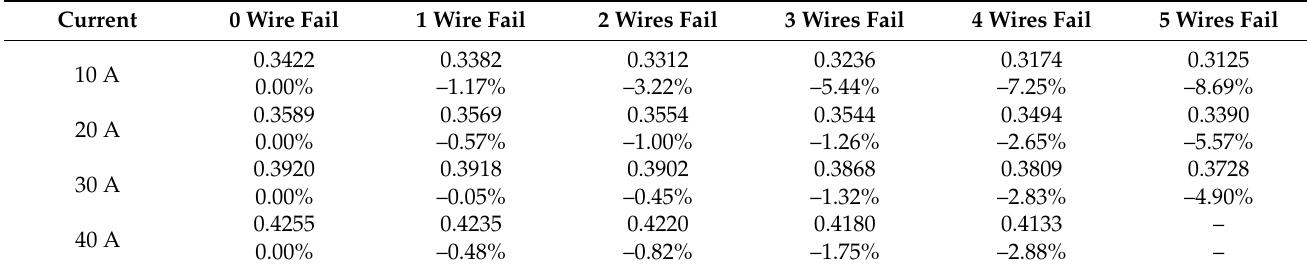
Table 3. Thermal resistance (K/W) under different working conditions after bond wires removed.